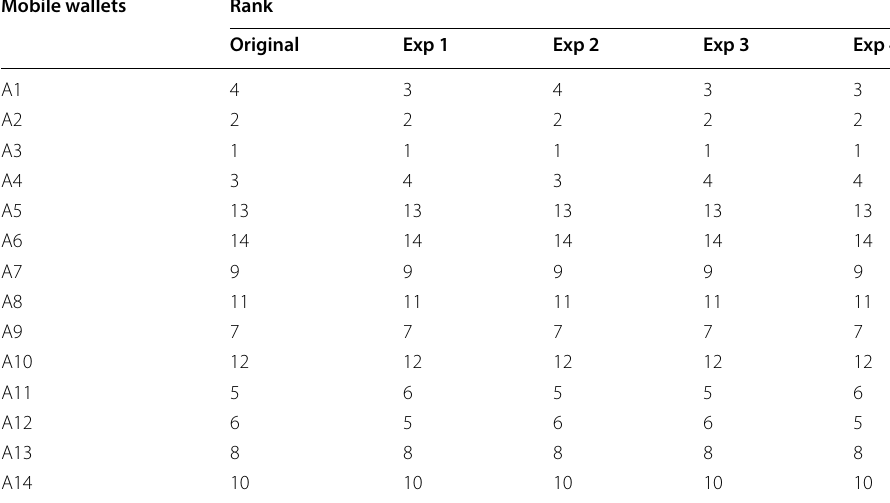
The bold cells indicate the exchange of criteria weights among them Table 16 Comparison of ranking orders (sensitivity analysis) Mobile